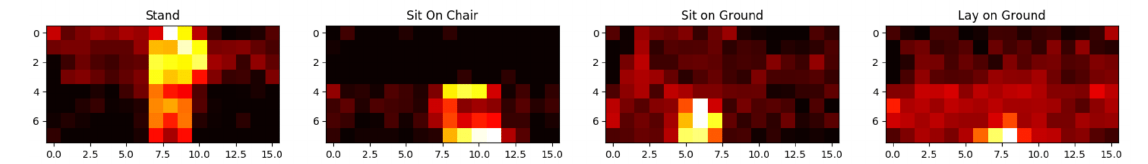
Figure 6. Static activities plotted as